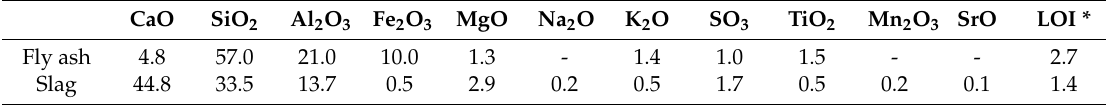
Table 1. Chemical compositions of the ground granulated blast-furnace slag (GGBS) and fly ash obtained by X-ray fluorescence (wt.%).